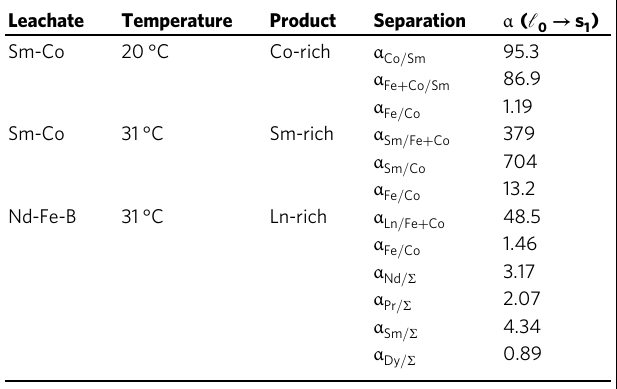
Table 1 Separation factors for DME-FC treatments of Sm-Co magnet leachate and Nd-Fe-B mixed magnet leachate for products depicted in Fig. 3.